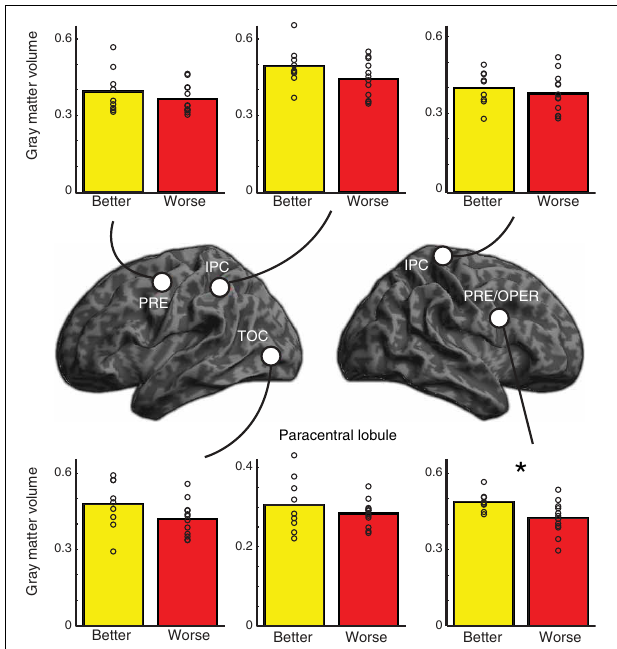
FIGURE 6 | Location of regions of interest (ROIs) used in gray matter analysis along with extracted gray matter data for better performing and worse performing older adults. P -values are one one-tailed t -tests for better-performing older adults having more gray matter than worse-performing older adults; ∗ indicates significant after controlling for multiple comparisons (see Table 3 ). Individual subjects’ extracted gray matter for each region are shown as unfilled circles. PRE, precentral gyrus; IPC, inferior parietal cortex; TOC, temporal occipital cortex; OPER, operculum. The paracentral lobule ROI is not shown on the